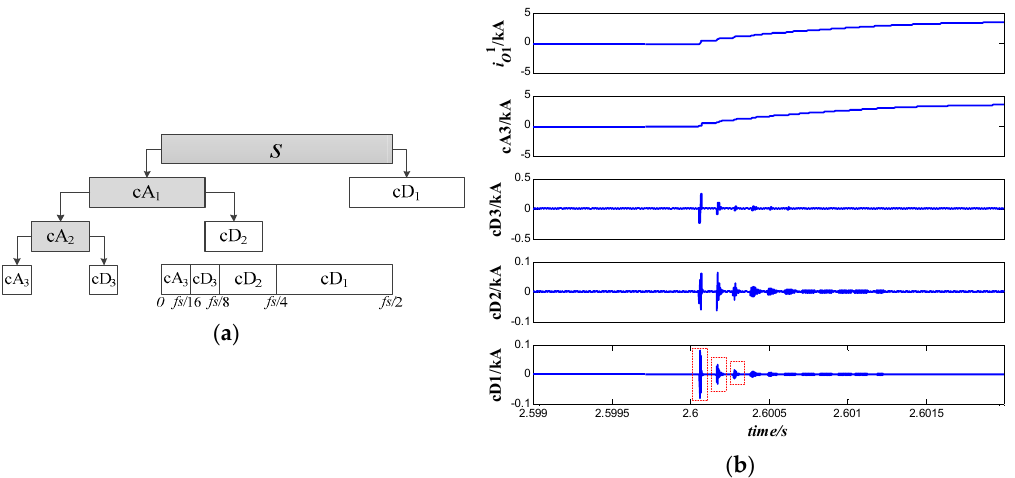
Figure 6. Introduction of wavelet decomposition: ( a )Schematic diagram of one-dimensional wavelet decomposition; ( b ). wavelet decomposition for 1-mode current that measured by observer 1.